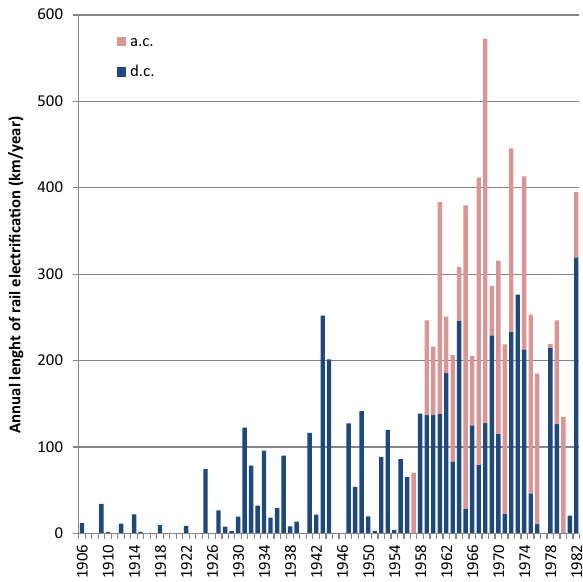
Fig. 4 Annual length of rail electrification in Japan National